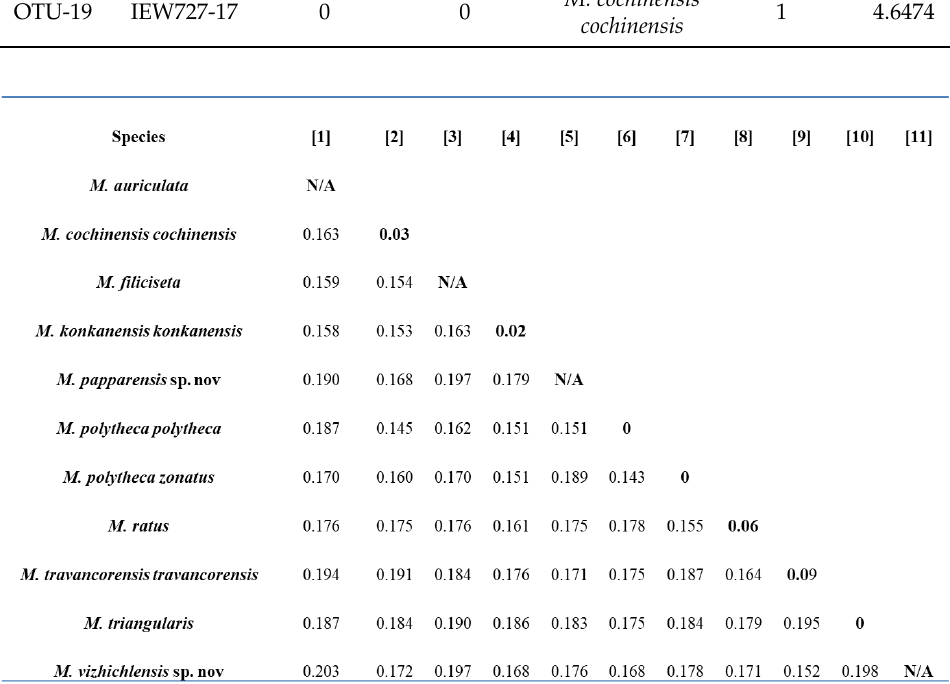
Figure 13. Intraspecific (bold diagonally) and interspecific uncorrected pairwise genetic distances of Megascolex species. Species with single COI sequence are represented by N/A. Table 2. Cluster Sequencing of COI barcodes of Megascolex species of Kerala depicting distances to nearest neighbour (NN).